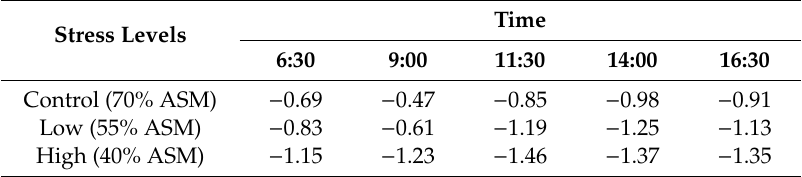
Table 3. Leaf water potential (MPa) of castor plants during the day (in MPa, mean values, n = 5). Stress Levels